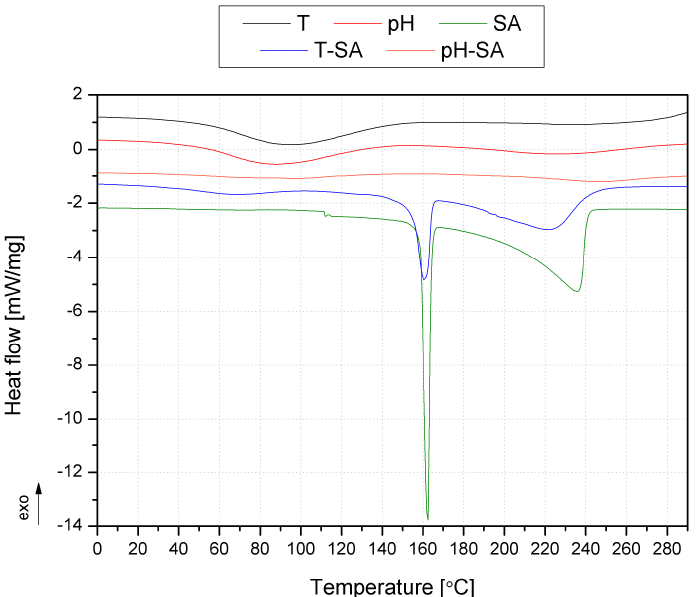
Figure 8. DSC thermograms of the thermo- and pH-sensitive nanocarriers, salicylic acid, and mixtures of nanocarriers with SA.